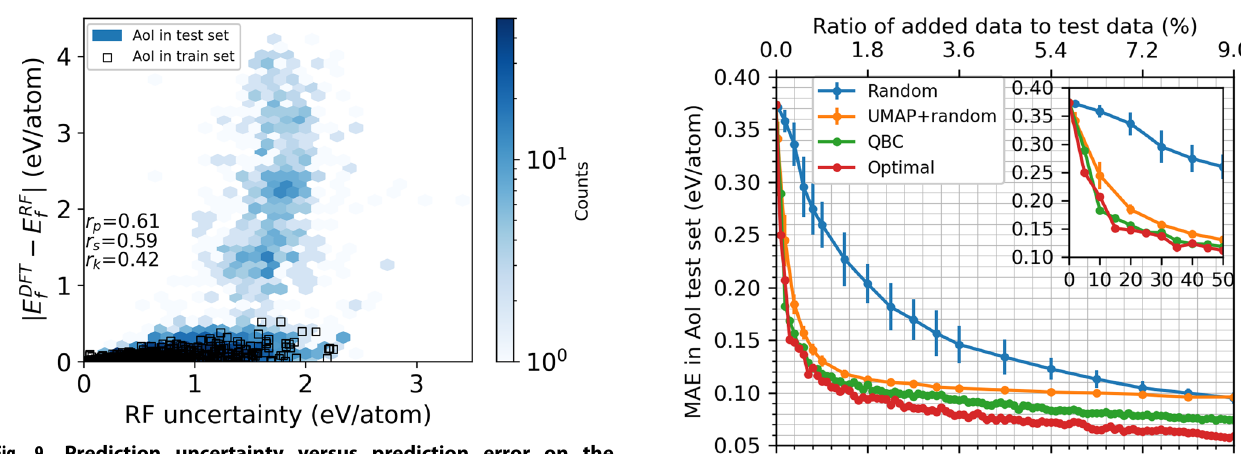
Fig. 9 Prediction uncertainty versus prediction error on the training and test AoI data for the MP18-pretrained RF model. The Pearson ( r p ), Spearman ( r s ), and Kendall ( r k ) correlation coef fi cients for the prediction uncertainties and errors of the test AoI data are shown for reference.